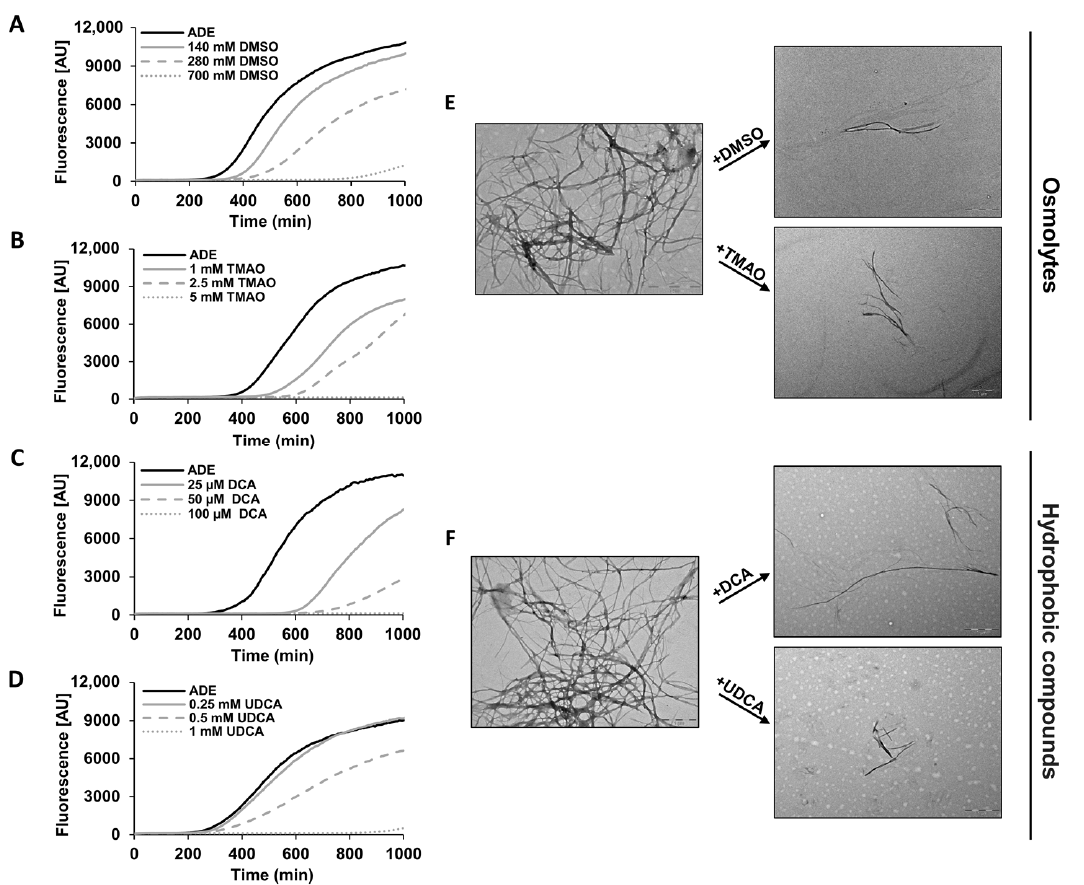
Figure 4. Inhibition of adenine fibril formation by different chemical chaperones in vitro. ( A – D ) Kinetic analysis of adenine aggregation as measured in a ThT binding assay. Adenine was dissolved at 6 mg/mL in PBS and heated to 90 ◦ C to obtain a monomeric solution, followed by the addition of the chemical chaperones at the indicated concentrations (see Materials and Methods). ThT was added to a final concentration of 40 µ M, and fluorescence was measured over time with excitation and emission wavelengths of 450 nm and 480 nm, respectively. The results are representative of three independent repeats. ( E , F ) Representative TEM micrographs of 1 mg/mL adenine in the presence or absence of the indicated chemical chaperone at 1.4 mM DMSO, 0.1 mM TMAO, 50 µ M DCA, and 50 µ M UDCA. Scale bar is 1 µ m. The images are representatives of three double-blinded repeats.